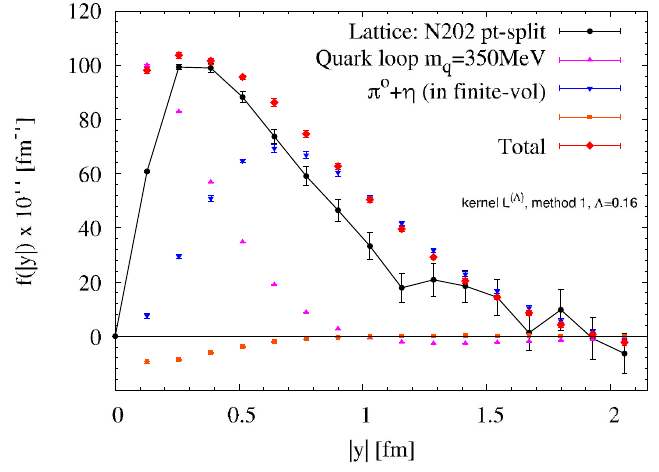
Figure 13 . Integrand for the connected contribution using Method 1 with L (Λ=0 . 16) on ensemble N202 of size 48 3 × 128 , lattice spacing 0.064 fm [88] with m π = m K = 421 MeV. The lattice data use a point-split current at x . The integrand is compared to the prediction for the pole